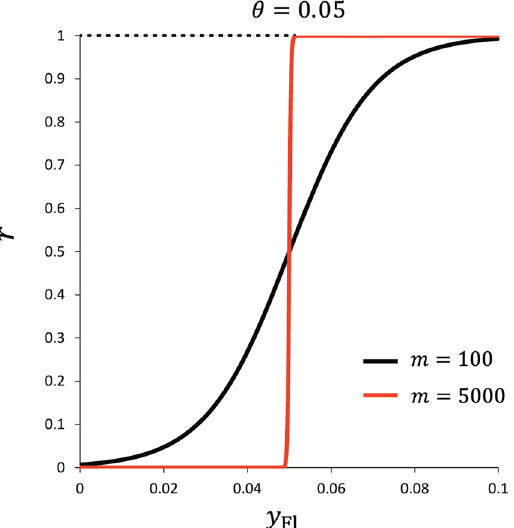
Figure 1. Examples of the function r . The function r in Eq. (2) indicates the probability that territory holders give up their own territories. This function depends on y Fl and two parameters m and θ , where m and θ denote the increasing gradient of r as a function of y Fl and the inflection point, respectively. r ( y Fl ) represents a logistic curve which has the inflection point θ and converges towards 1 as y Fl increases (black line). When m is sufficiently large, r ( y Fl ) approximates a step function which has the threshold θ (red